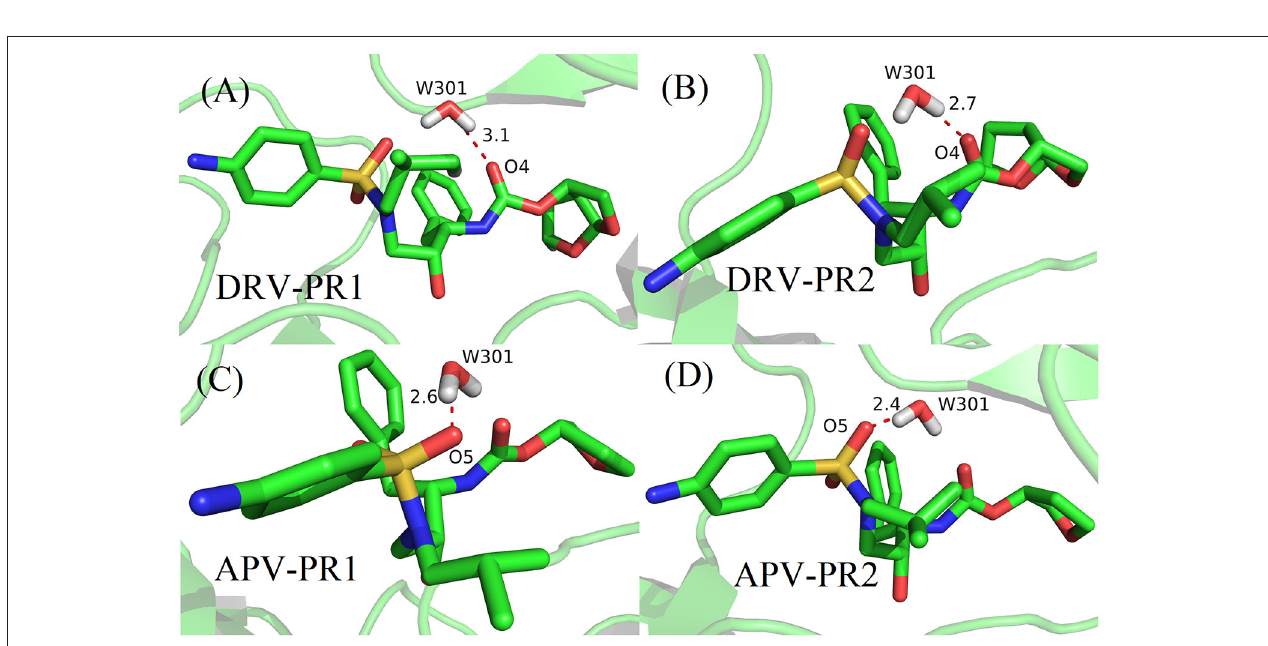
FIGURE 9 | The geometrical positions of bridging water and inhibitors based on the lowest potential energy structure from MD trajectory. (A) DRV-PR1 complexes. (B) DRV-PR2 complexes. (C) APV-PR1 complexes. (D) APV-PR2 complexes.